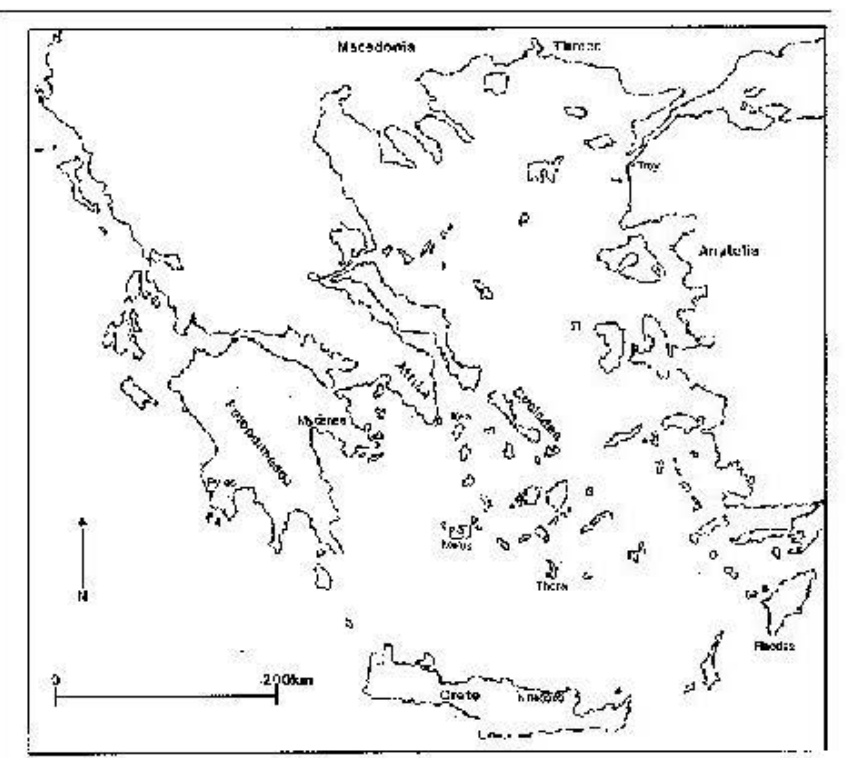
figure I. Map of the Aegean !iho-wing some of the locations mentioned in the